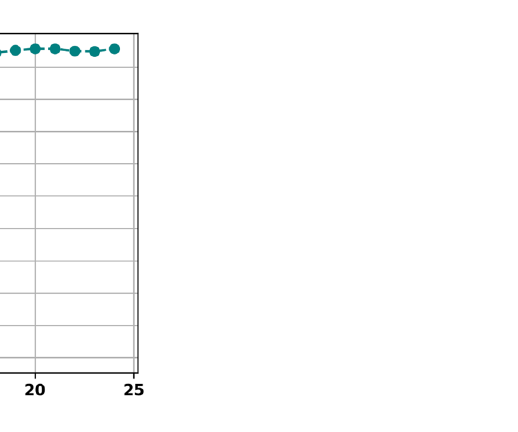
Figure 4. Accuracy variation of the number of